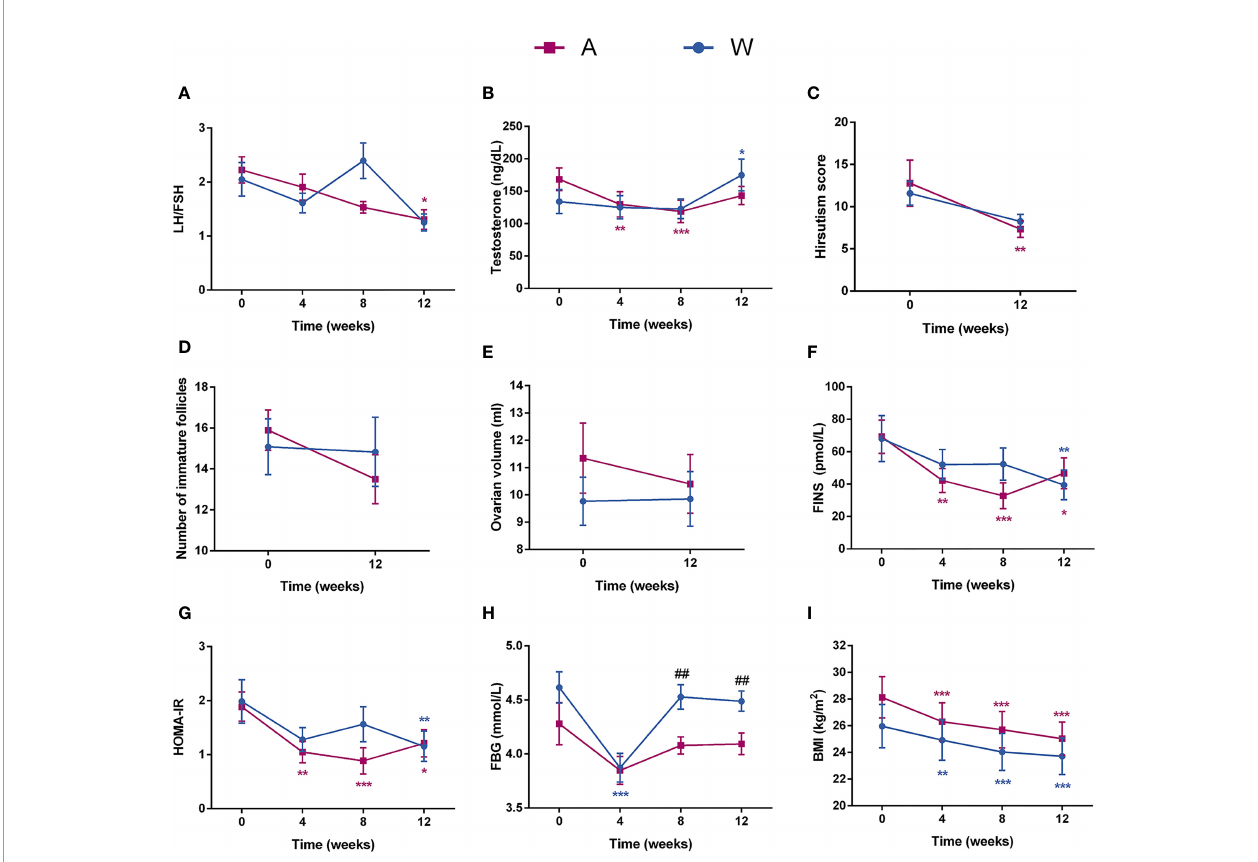
FIGURE 2 | The sex hormonal and metabolic disorders were improved in patients with PCOS after the intervention. Changes in (A) the LH/FSH ratio, (B) testosterone, (C) hirsutism score, (D) number of immature follicles, (E) ovarian volume, (F) FINS, (G) HOMA-IR, (H) FBG, and (I) BMI for participants during the intervention are shown. Date expressed as mean ± SEM. * p < 0.05, ** p < 0.01, and *** p < 0.001 for comparison with the week 0 value for the same group, red for A group and blue for W group. ## p < 0.01 for comparison of A group with W group value at the same time point. LH, luteinizing hormone; FSH, follicular stimulating hormone; FINS, fasting plasma insulin; HOMA-IR, homeostasis model assessment for insulin resistance index; FBG, fasting blood glucose; BMI, body mass